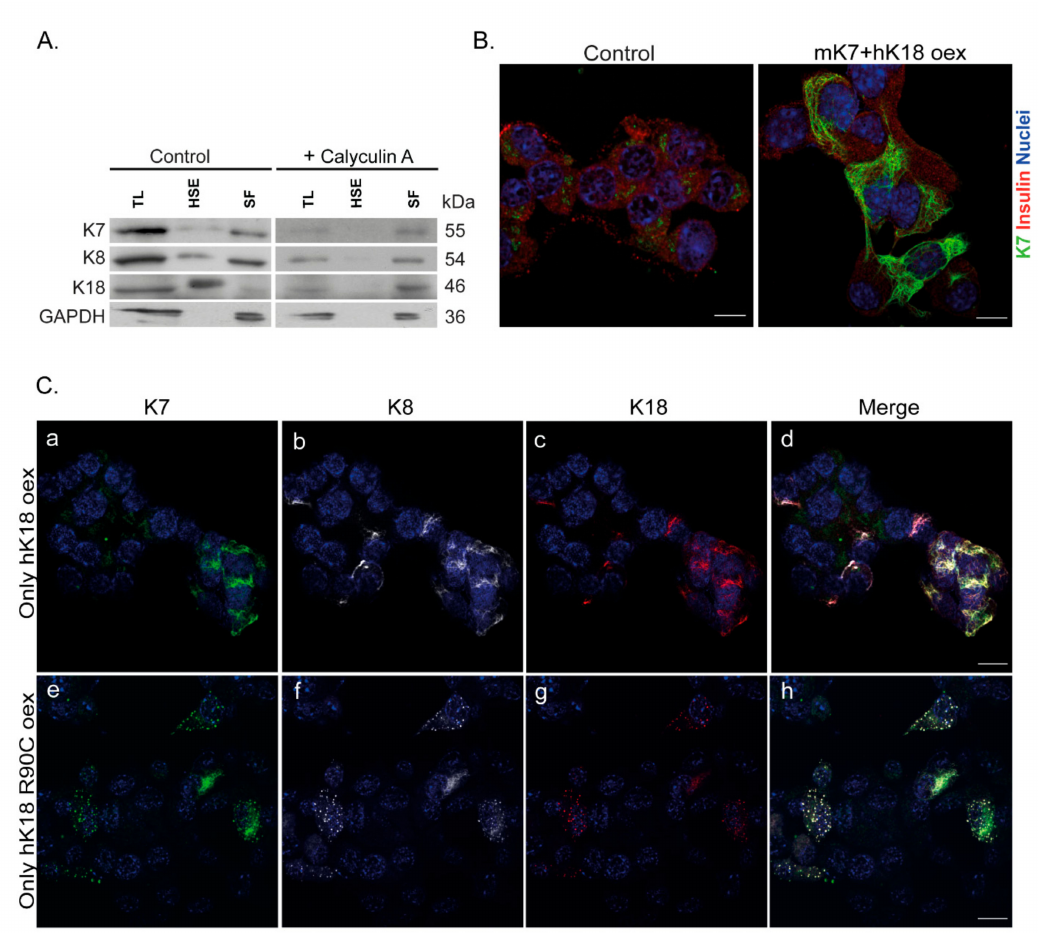
Figure 4. K7 filament formation and levels in MIN6 β -cells is dependent on K18 levels. ( A ) Immunoblots of keratin high salt extraction (HSE) from total lysate (TL) of MIN6 β -cells show the endogenous K7, K8 and K18 in insoluble (HSE) and soluble (SF) form. The soluble K7 fraction could be further increased, if treating the cells with calyculin A. For visualization, the HSE samples were loaded in gel for untreated cells 10-fold, and for calyculin A treated cells 20-fold, more compared to the SF samples. ( B ) MIN6 β -cells transfected with mK7/hK18, formed proper keratin filaments shown in the immunostaining of cells for K7 (green), insulin (red) and nuclei (blue). Scale bar = 10 µ m. ( C ) MIN6 β -cells transfected with only hK18 or hK18 R90C (oex) and stained for K7 (green), K8 (grey) and K18 (red). The images ( a – d ) show an increased K7/K8/K18 filament formation in cells transfected with hK18. Expressing hK18 R90C in MIN6, lead to similar cytoplasmic K7/K8/K18 dots ( e – h ) found in vivo. Scale bar = 20 µ m. n =